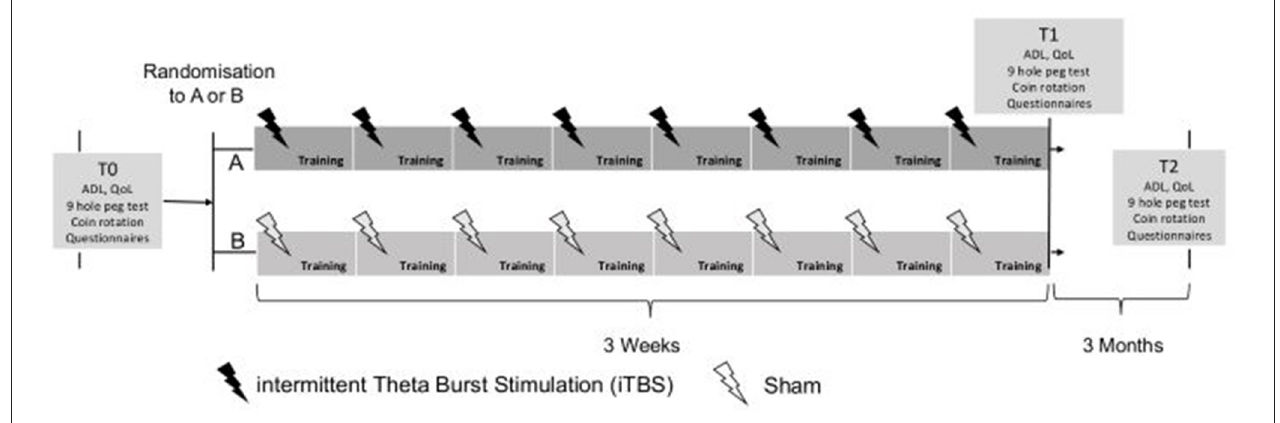
FIGURE 1 | Design of study: T0 baseline assessment, T1 end of training, T2 follow-up after 3 months. ADL, activities of daily living; QoL, quality of